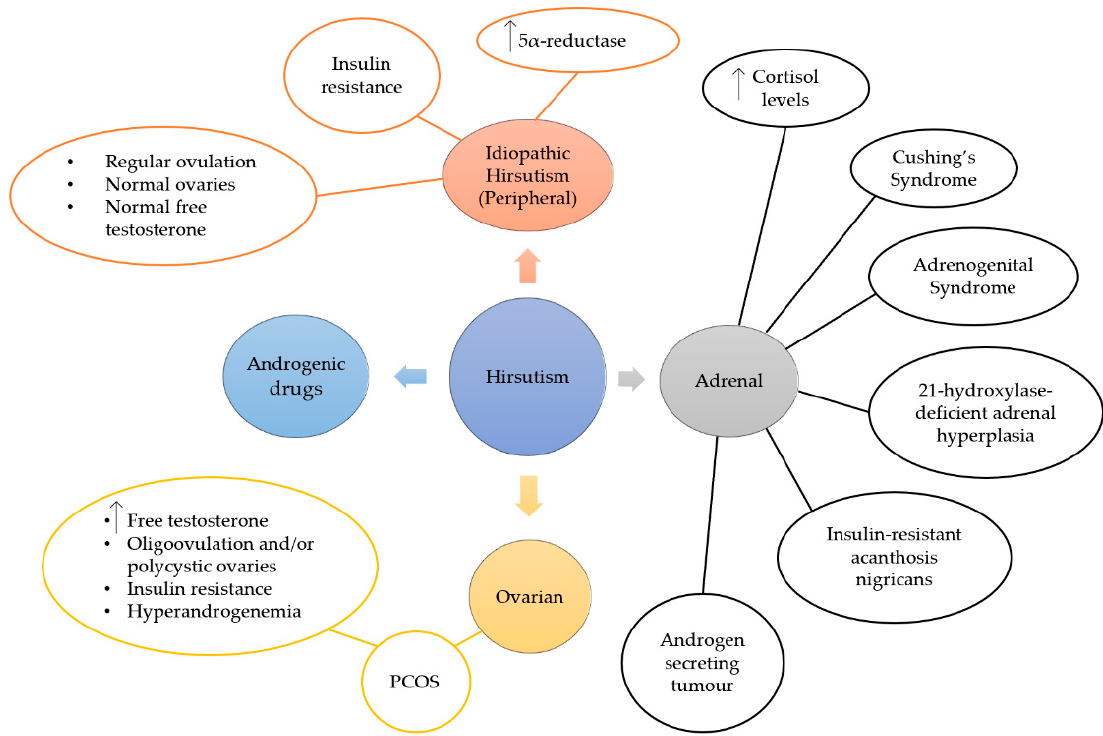
Figure 2. Hirsutism can originate from adrenal or ovarian disorders, or both. Various syndromes and disorders related to the adrenal glands, such as Cushing’s syndrome, adrenogenital syndrome, 21-hydroxylase-deficient adrenal hyperplasia, insulin-resistant acanthosis nigricans and androgen secreting tumour, show high levels of cortisol hormone and hirsutism. Ovarian hirsutism is caused by PCOS that is characterised from high levels of free testosterone and/or polycystic ovaries, insulin resistance and hyperandrogenemia. Idiopathic hirsutism is caused by peripheral increase of androgens, and women that suffer from it show increased levels of 5 α -reductase and insulin resistance, whilst they do not show any abnormalities in their ovarian or adrenal function.